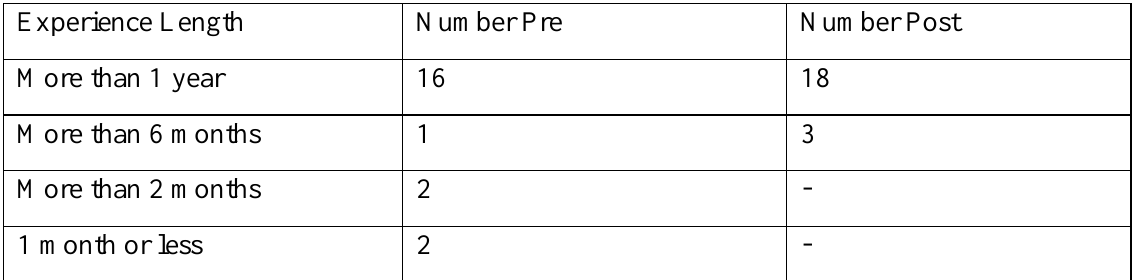
Table 1: Table of Experience with Technology